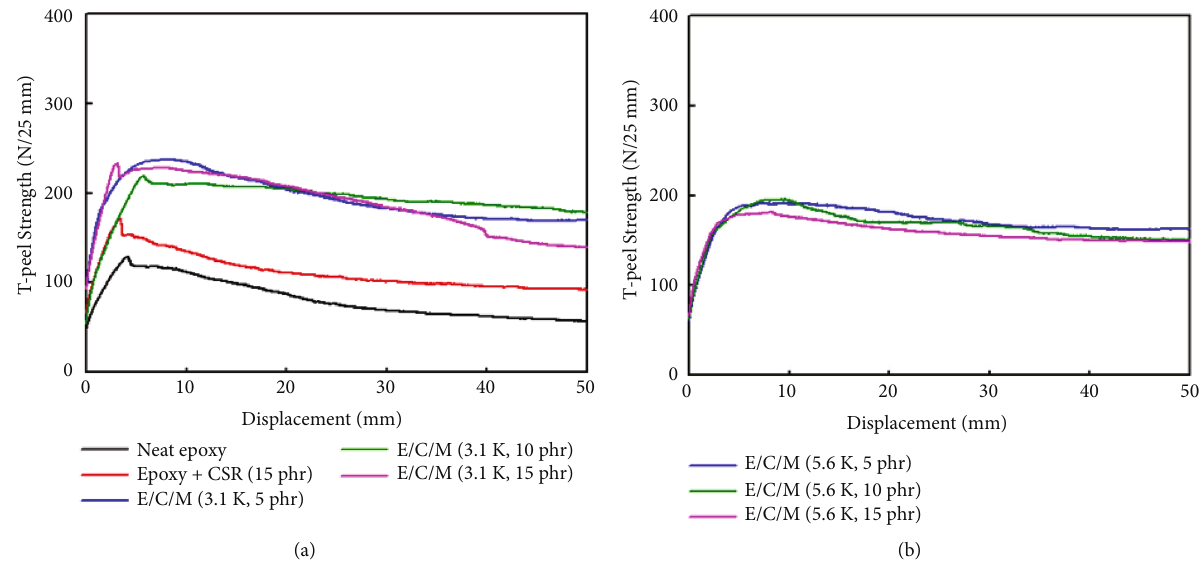
Figure 4: T-peel strength – displacement curves for (a) E/C/M (3.1 K) and (b) E/C/M (5.6 K) with di ff erent phr conditions.